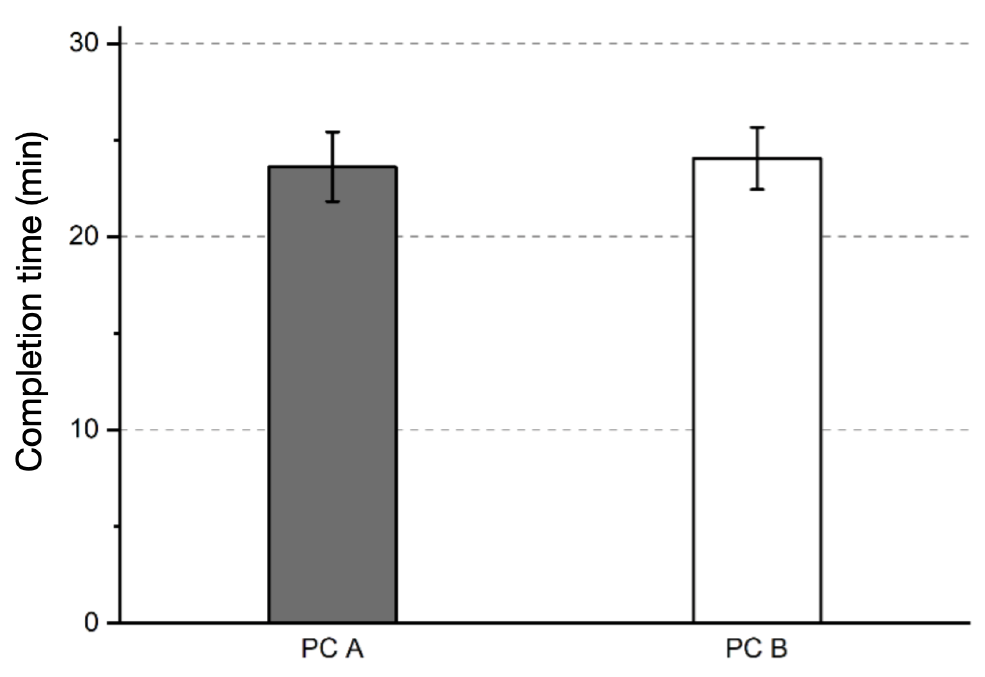
Figure 35. The mean of completion time of PC assembly task. Error of Task Implementation Hypothesis 2. Figure 36 illuminates the box chart of average errors during the implementation in the engine maintenance task. A Shapiro–Wilk test implied that the data were not normally distributed. Thus, a Kruskal–Wallis test was performed, unveiling no significant differences among Engine A-1 (Md = 1.5 and n = 8), Engine A-2 (Md = 3 and n =